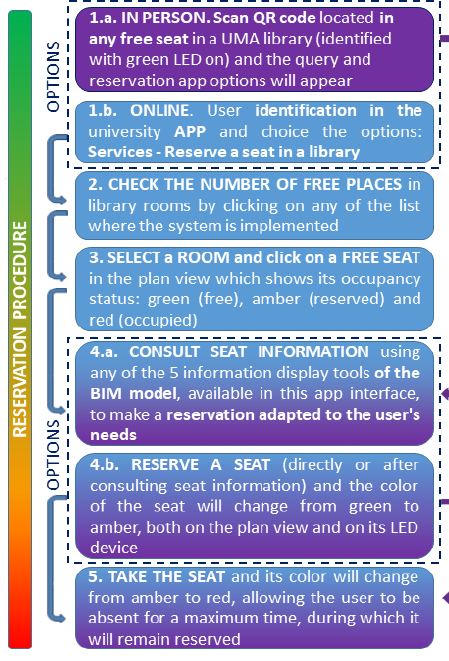
and displays the seat as occupied (red) on the interface and on its corresponding